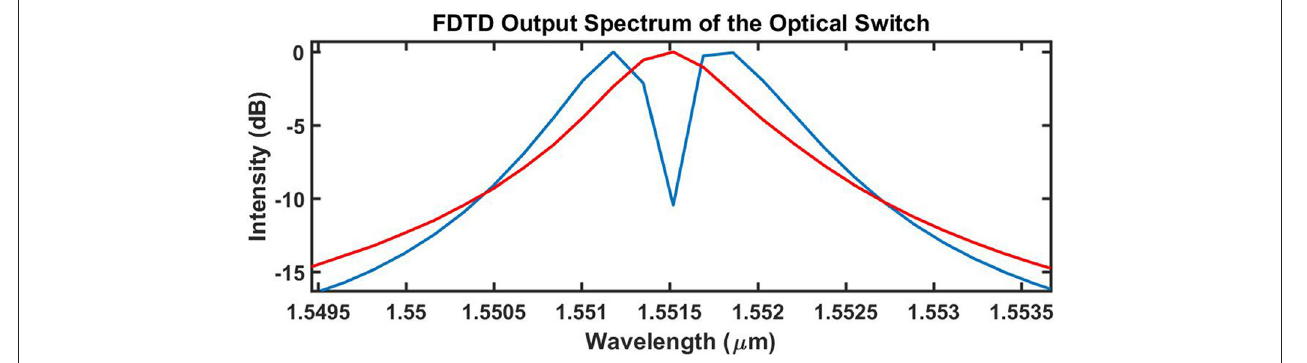
FIGURE 4 | The 3D FDTD simulation combined drop (Iout) output